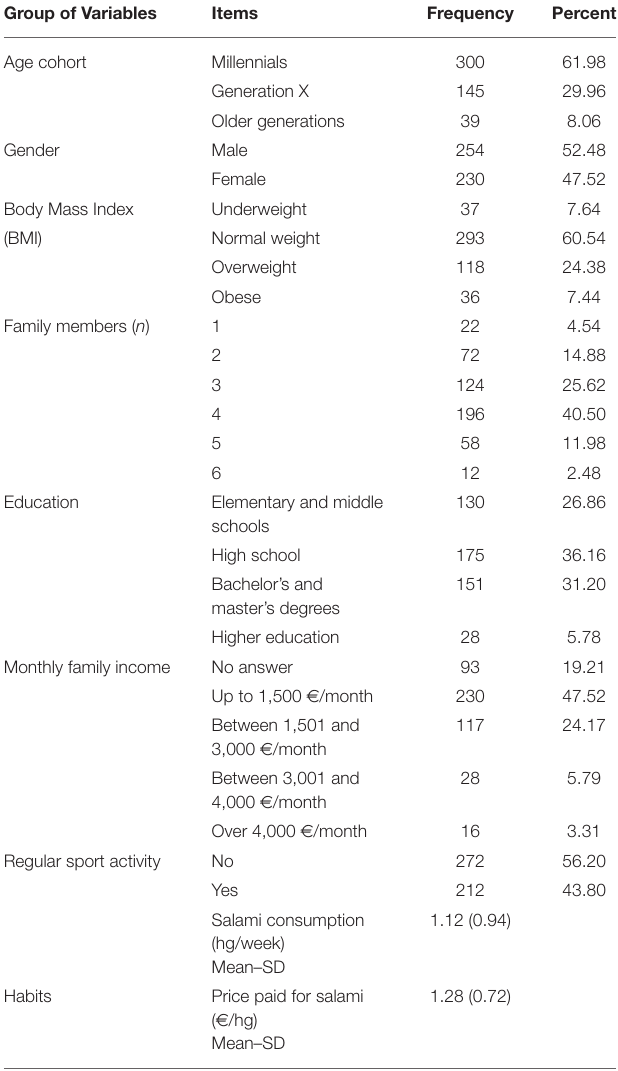
TABLE 1 | Socio-demographic characteristics and consumption habits of the sample ( n = 484). Group of